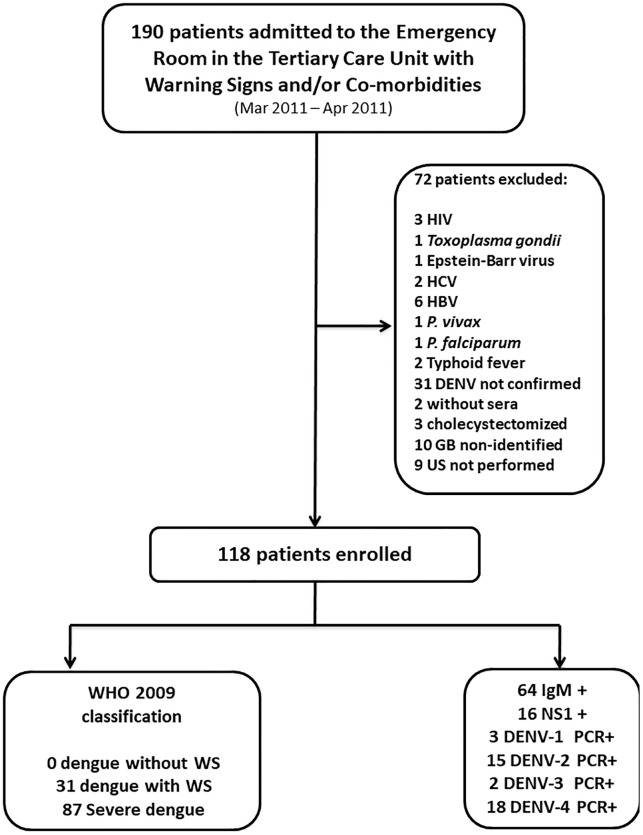
Breakdown of patient enrollment, exclusions and classifications.